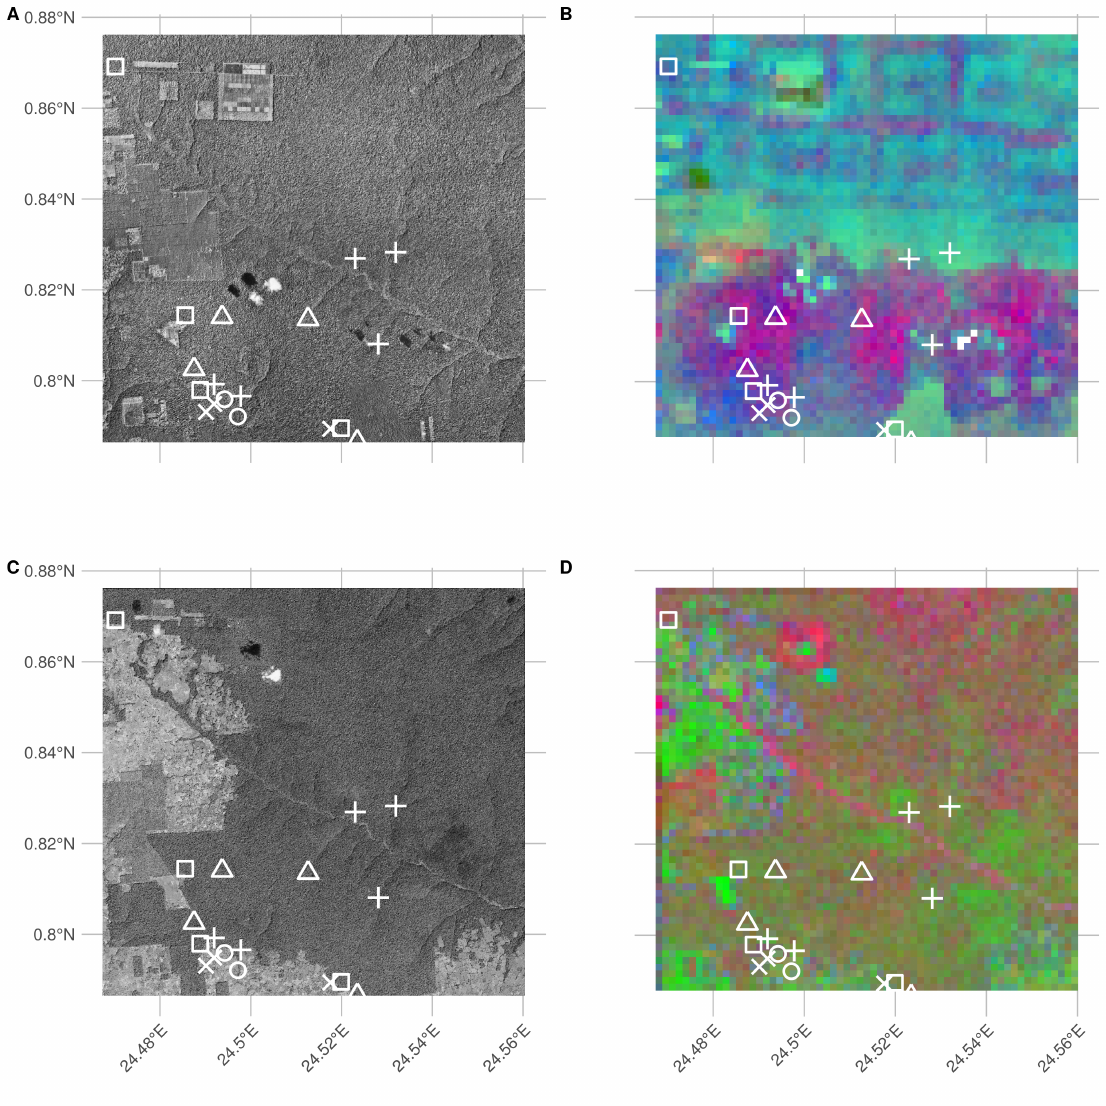
Figure 10. Black and white overview images and red-green-blue (RGB) visualizations of the first three principal components of scene-wide FOTO texture analysis of historical ( A , B ) and current (Geo-Eye, C , D ) imagery: Current permanent sampling plots of mono-dominant, mixed, fallow, and young (edge) forest plots are marked with open triangles, open circles, open squares, and crosses,